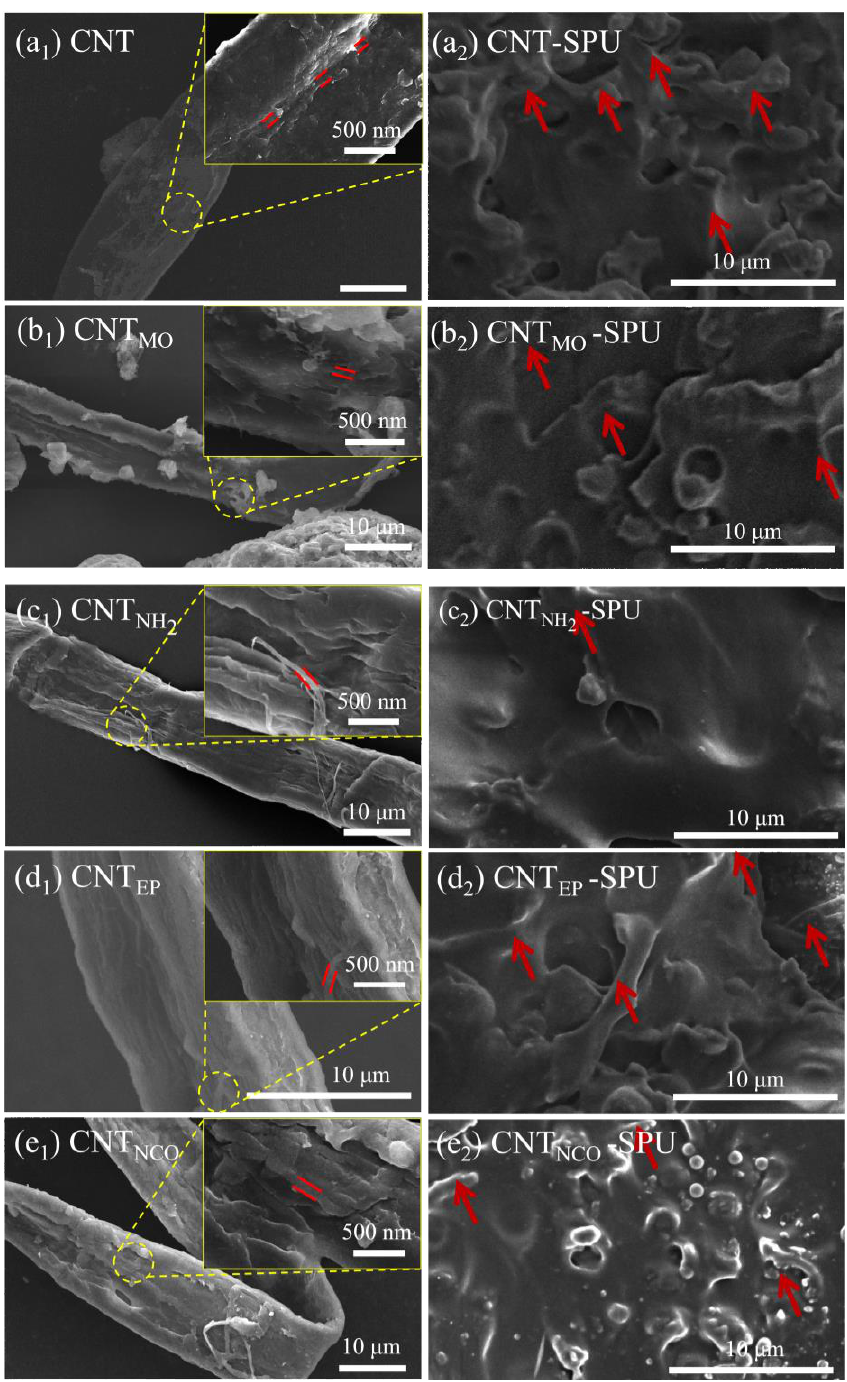
Figure 4. Scheme of surface changes of modified CNT . ( a ) CNT MO ; ( b ) CNT NH2 ; ( c ) CNT EP ; ( d ) CNT NCO .